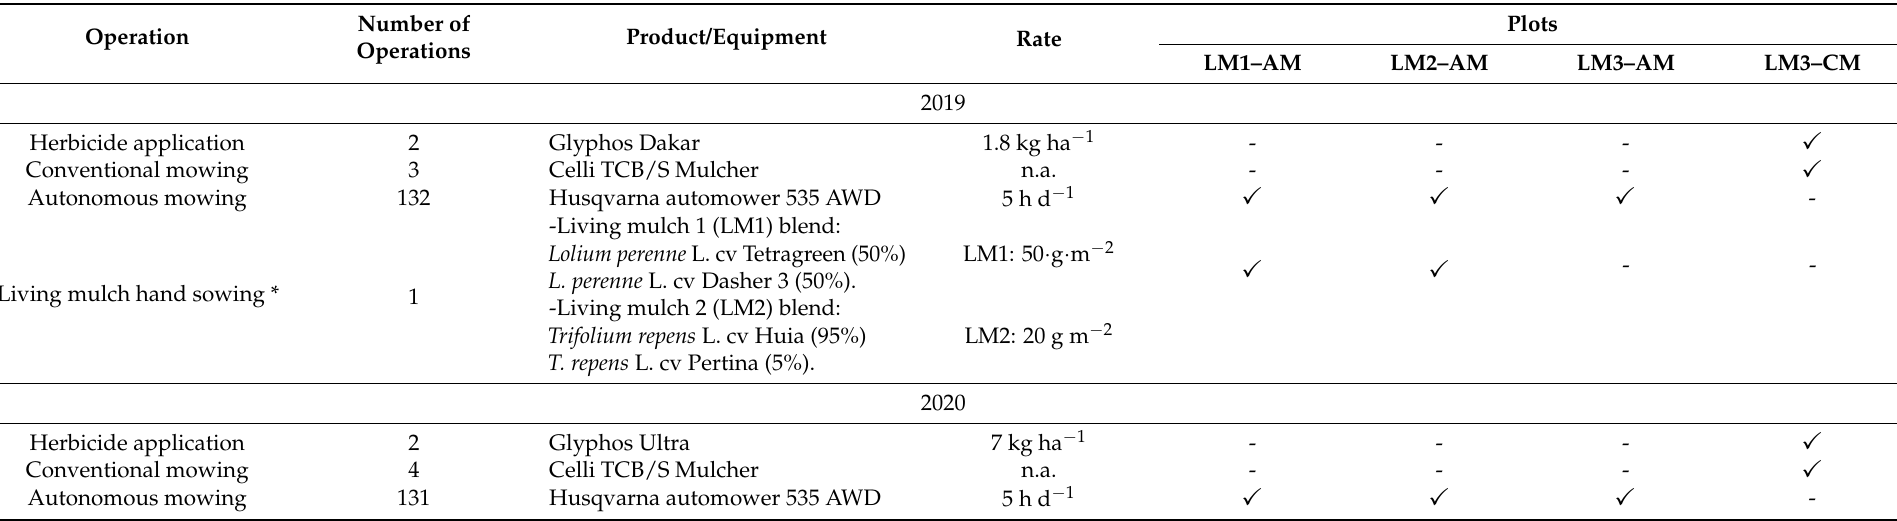
Table 1. Trial operations program for 2019 and 2020.